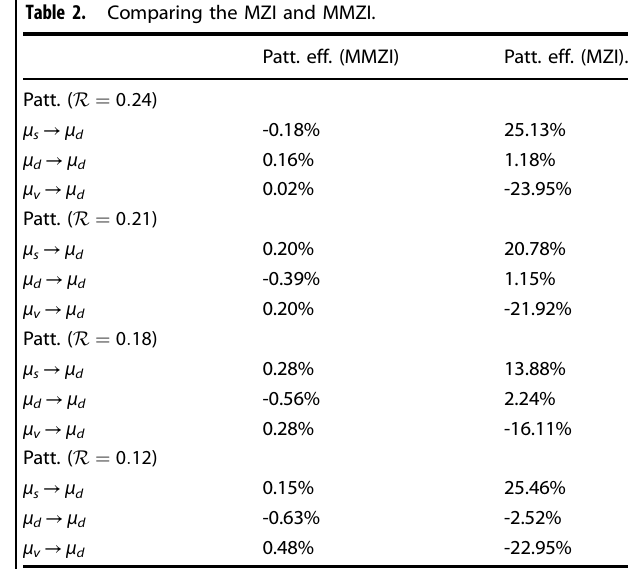
which re fl ects the patterning effect.